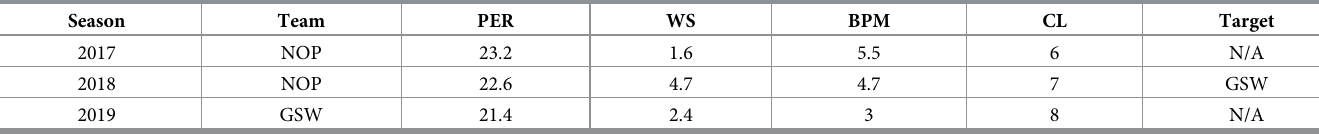
Table 3. Three years of collected and engineered data for our representative basketball player. At the conclusion of the 2018 season, this player transitioned from the New Orleans Pelicans (NOP) to the Golden State Warriors (GSW) so the target variable was set to be GSW.